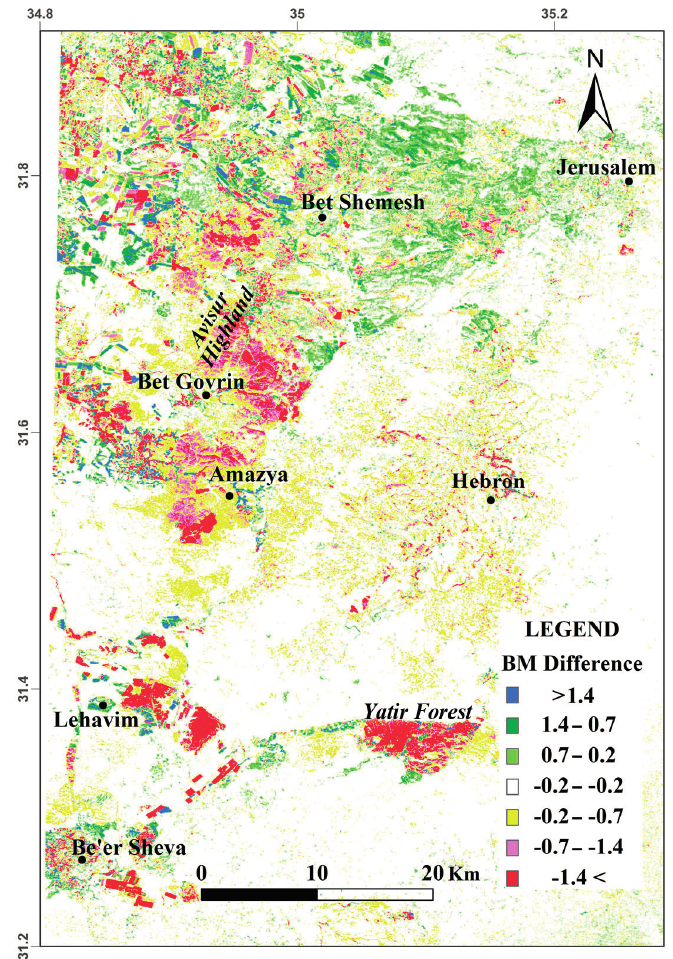
Figure 12. Deviations between the two biomass maps (Figure 8) of the early (1994–1996) and late (2009–2011) periods. Squares: location of detailed analysis units (2 × 2 km in